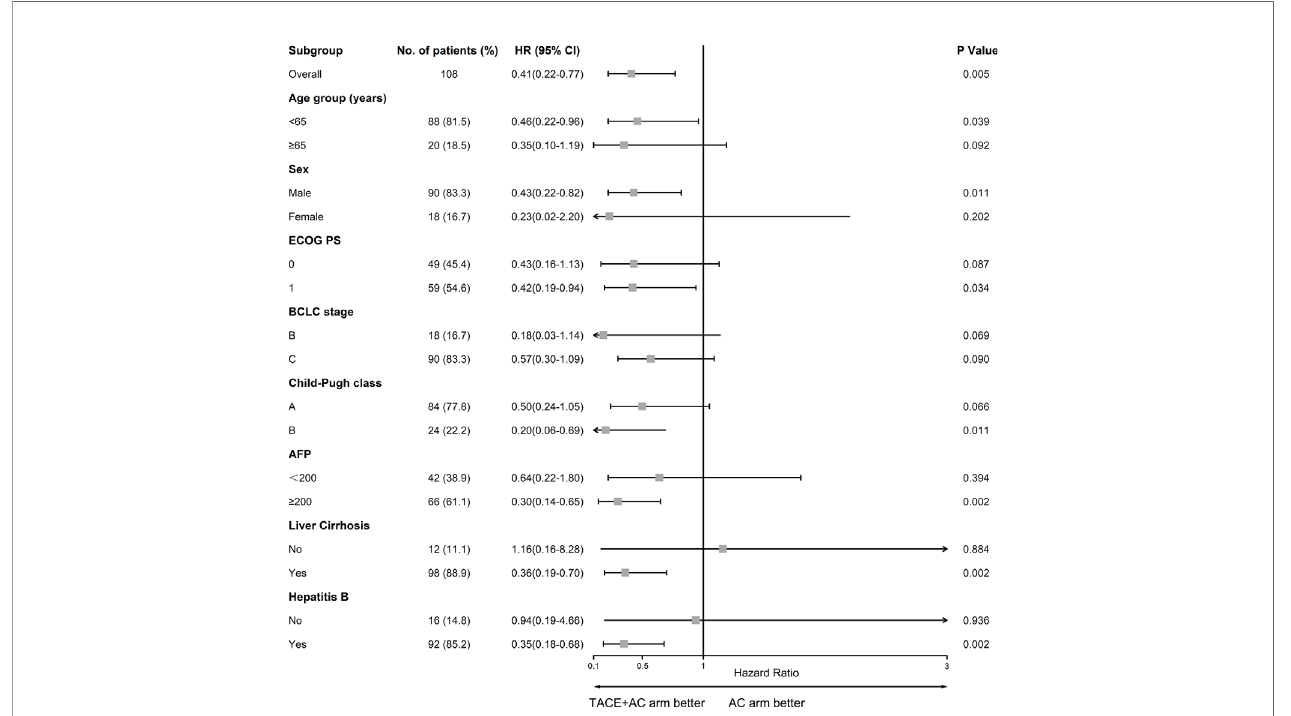
FIGURE 3 | Forest plot of OS in subgroups of patients treated with TACE plus apatinib plus camrelizumab and apatinib plus camrelizumab. TACE, transcatheter arterial chemoembolization; ECOG PS, Eastern Cooperative Oncology Group Performance Status; BCLC, Barcelona Clinic Liver Cancer; AFP, alpha-fetoprotein.